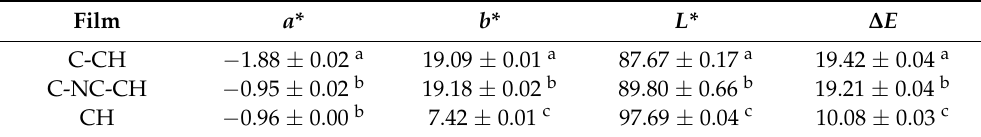
Table 3. Film colors.